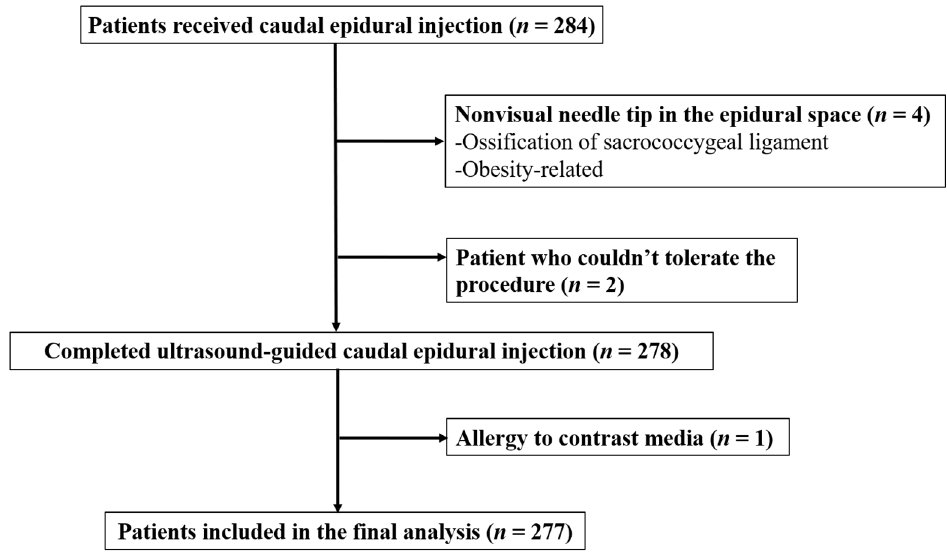
Figure 3. Flow diagram for patient selection.